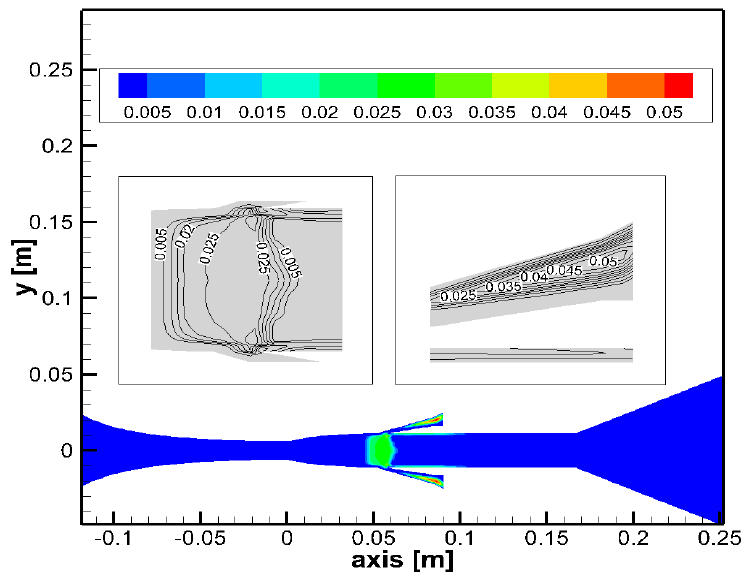
Figure 19. Humidity distribution along the axial cross-section of the supersonic separator.